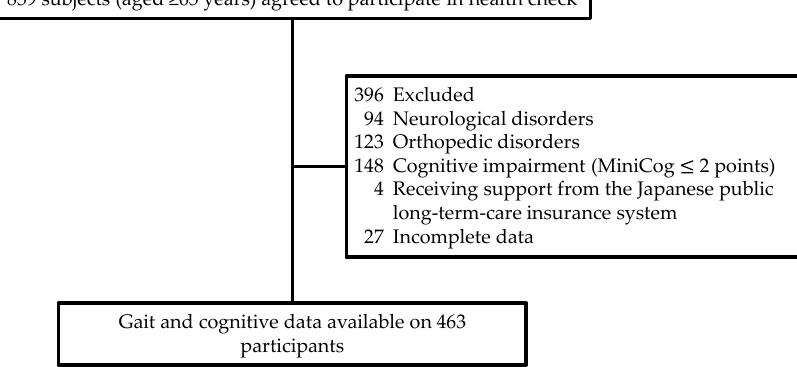
Figure 1. Subject flow diagram from initial contact through to study completion.